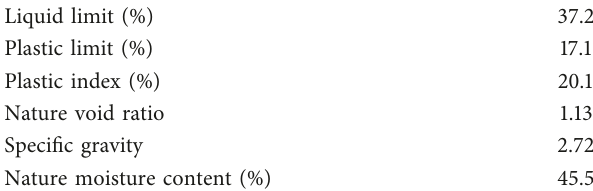
Table 2: Some properties of clayey soil.